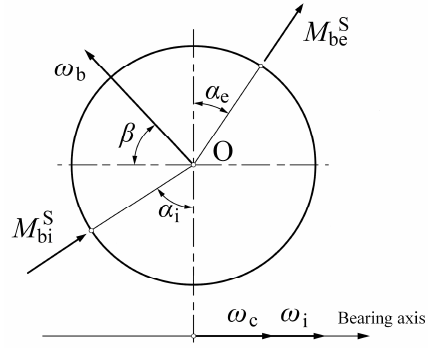
Figure 1. Geometrical configuration of a shaft-bearing system.